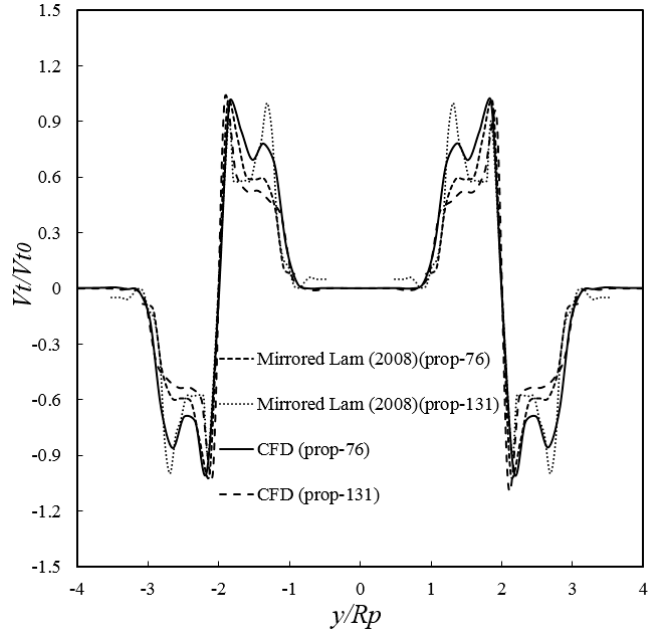
Figure 11. Tangential velocity distributions at the efflux plane.